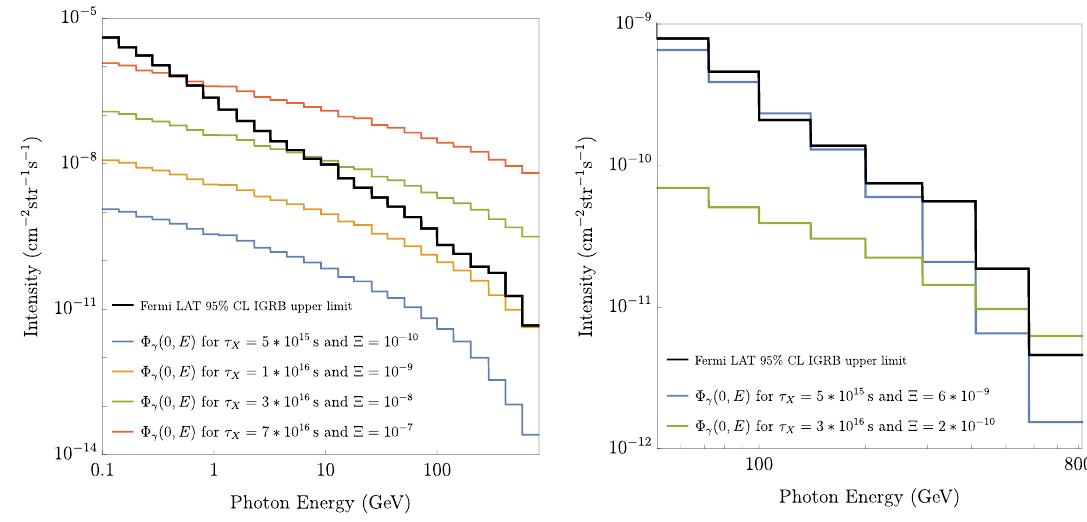
Figure 3 . Comparison of the Fermi LAT 95% CL IGRB upper limit with the derived di(cid:11)use isotropic (cid:13) -ray (cid:13)ux (cid:8) (cid:13) (0 ; E ) produced by a decaying heavy relic X for di(cid:11)erent lifetimes and abundances. The blue line in the left plot corresponds to the black dot in (cid:12)gure 2, which is the abundance necessary to obtain the model I (cid:12)t shown in (cid:12)gure 4. Since (cid:8) (cid:13) (0 ; E ) scales linearly in intensity with (cid:4) the spectra for the brown dot (model II (cid:12)t shown in (cid:12)gure 4) and red dot (model II (cid:12)t shown in (cid:12)gure 5) can be obtained by multiplying the blue line by a factor of 7 2 , respectively. Shorter lifetimes ( / 8 (cid:3) 10 15 s) are most stringently constraint by the energy range 3 between 100{140 GeV. For longer lifetimes the highest energy range from 580{820 GeV has the highest constraining